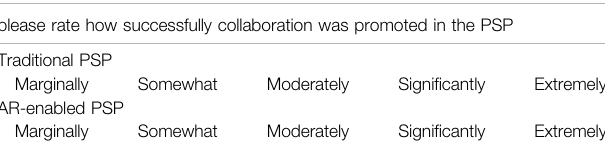
TABLE 5 | Example of a question to compare the collaboration between the traditional and AR-enabled PSP. please rate how successfully collaboration was promoted in the